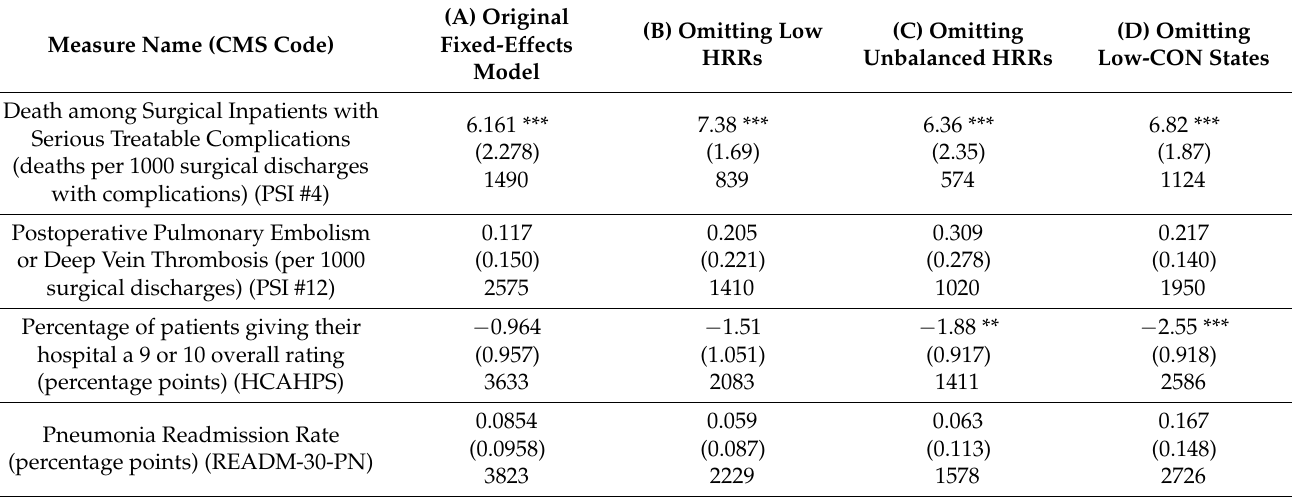
Table 10. Robustness checks